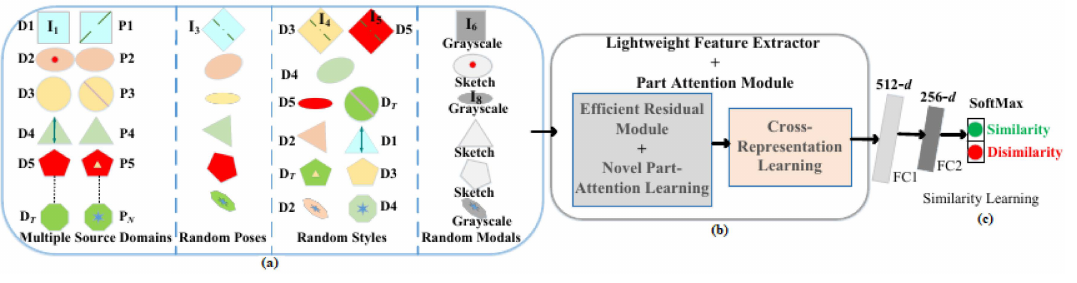
Figure 2. Framework of domain generic metric M G . ( a ) Real Open-world Training Data. ( b ) Lightweight Features Extractor with Novel Attention and Cross-Representation. ( c ) Similarity